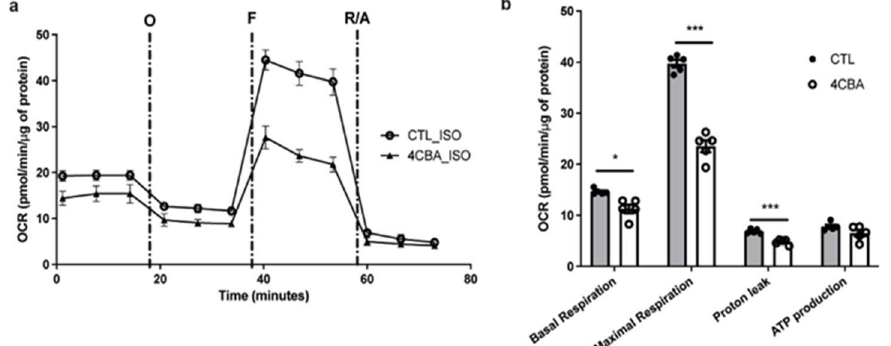
Figure A1. ( a ) Oxygen consumption rate (OCR) of isoproterenol and BSA-treated brown adipocyte cells were measured using SeaHorse XFe24 analyzer and components of mitochondrial respiration were analyzed, n = 5. ( b ) Basal, maximal, and proton leak OCR was decreased in 4CBA-treated cells compared to cells treated with vehicle (CTL). Data represent mean ± SEM. Significance presented at * p < 0.05, and *** p < 0.001 compared to controls or otherwise indicated.